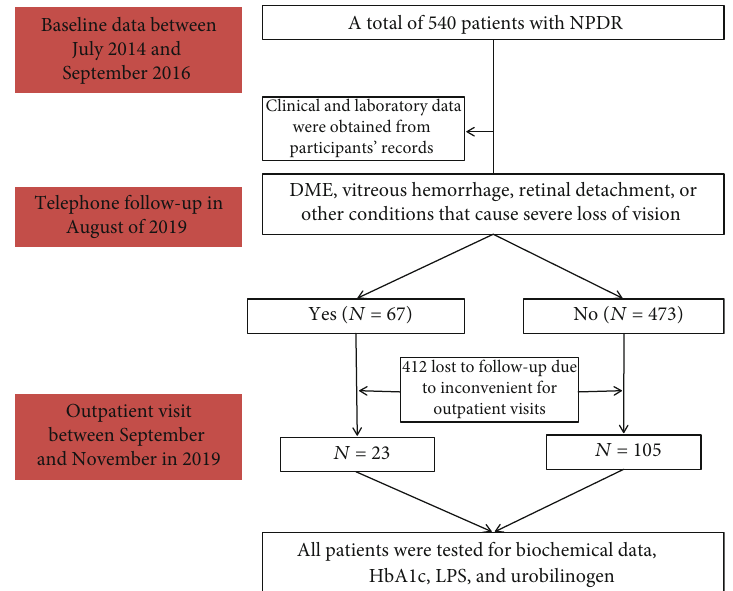
Figure 1: Flow chart of inclusion